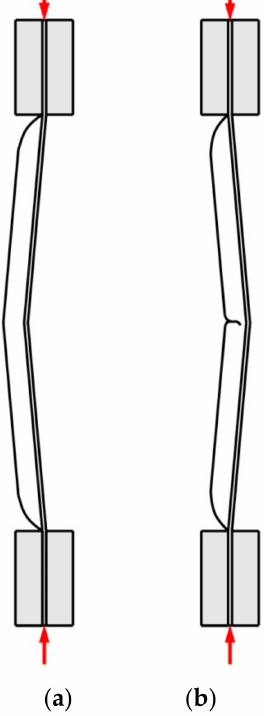
Figure 7. Modes of panel buckling: ( a ) Mode A—the panels buckled halfway up the panel width towards the rib, without any appreciable loss of rib stability and ( b ) Mode B—the rib first lost stability at half height, which was associated with breakage of the rib, and then the panel was deflected in the opposite direction to the position of the rib